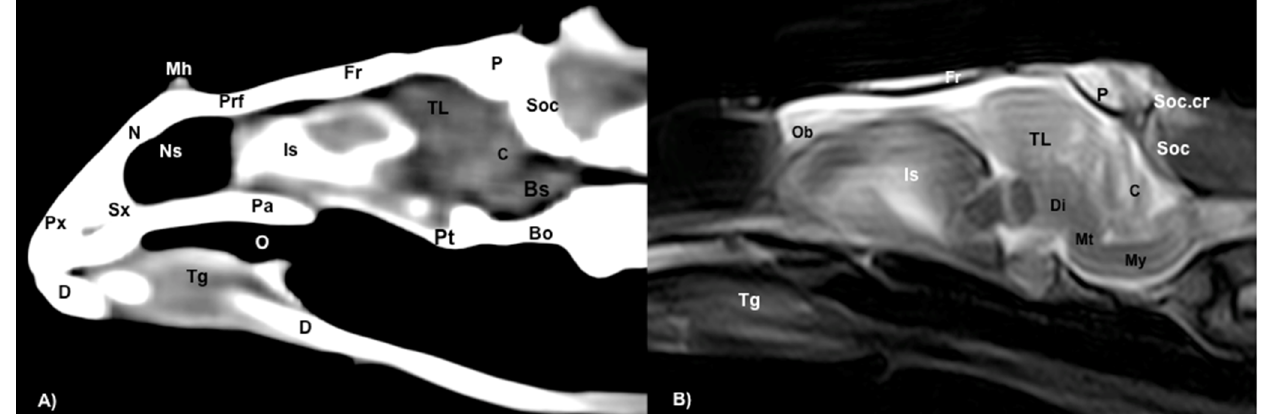
Figure 8. ( A ) Mid ‐ sagittal CT image in the brain window. ( B ) Sagittal MRI in the T2W sequence image of the head of rhinoceros iguana. Px: Premaxillary bone. Sx: Septomaxilla. D: Dentary bone. N: Nasal bone. Mh: Medial horn. Prf: Prefrontal bone. Pa: Palatine bone. O: Oral cavity. Tg: Tongue. Fr: Frontal